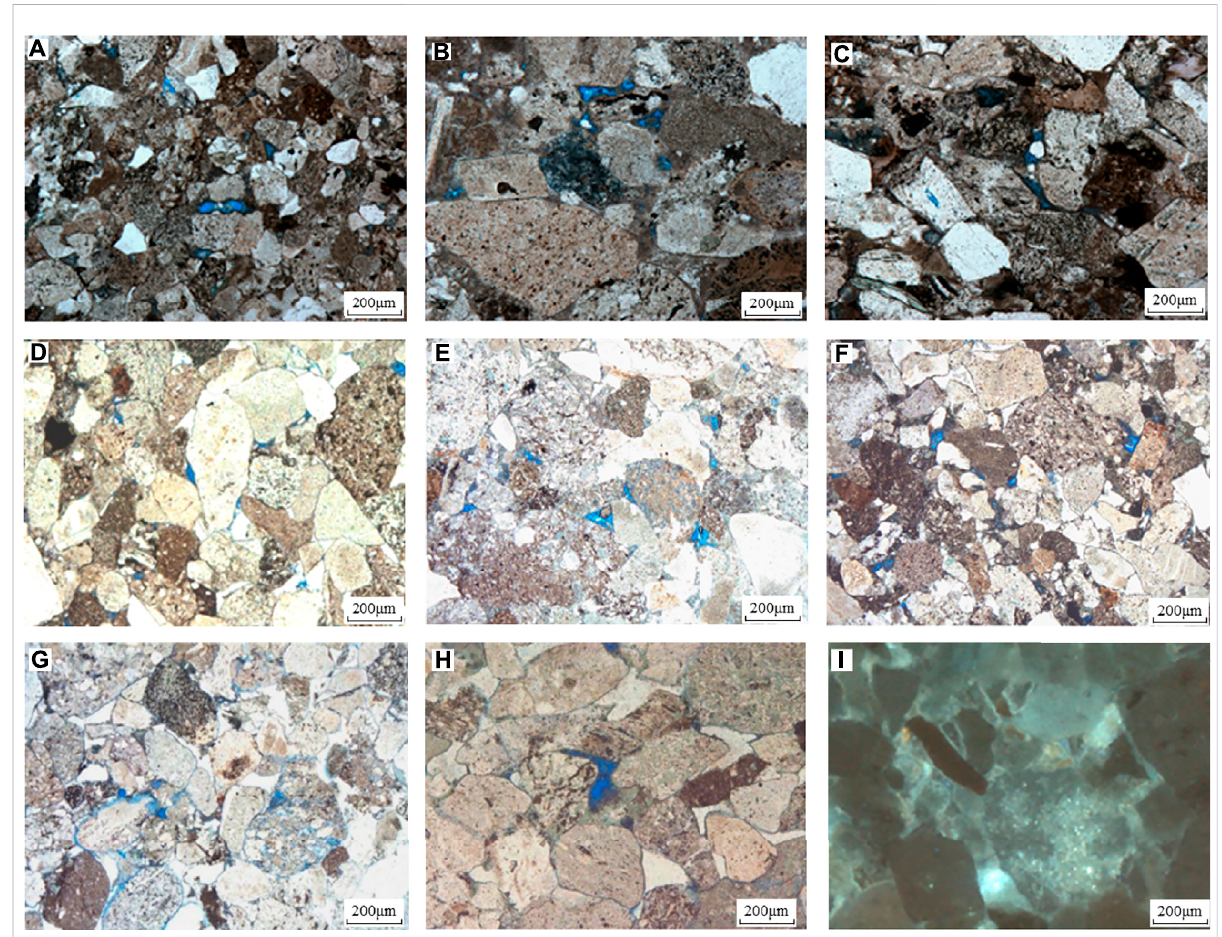
FIGURE 4 Microscopic thin section photos of pore types of the Permian Upper Wuerhe Formation reservoirs in the Dinan 15 well block. (A) Glutenite, intergranular pores 95%, intragranular dissolution pores 5%, Dinan 19 well, 3,926.8 m (P 3 w 1 ); (B) Glutenite, intergranular pores 95%, intragranular dissolution pores 5%, Dinan 19 well, 3,922.57 m (P 3 w 1 ); (C) Glutenite, intergranular pores 60%, intragranular dissolution pores 25%, tectonic fracture 15%, Dinan 19 well, 3,927.05 m (P 3 w 1 ); (D) Medium sandstone, intergranular pores 95%, intragranular dissolution pores 4%, laumonite dissolution pores 1%, Dinan 14 well, 4,005.52 m (P 3 w 1 ); (E) Sandy conglomerate, intergranular pores 60%, intragranular dissolution pores 30%, intergranulardissolutionpores10%,Dinan15well,3,927.9 m(P 3 w 2 ); (F) Sandyconglomerate,intergranularpores70%,intergranulardissolutionpores 20%,intragranulardissolutionpores10%,Dinan15well,3,932.1 m(P 3 w 2 ); (G) Sandyconglomerate,intergranularpores50%,intergranulardissolution pores 20%, particle-edge fractures 20%, intragranular dissolution pores 10% Dinan 15 well, 3,728.87 m (P 3 w 2 ); (H) pebbly